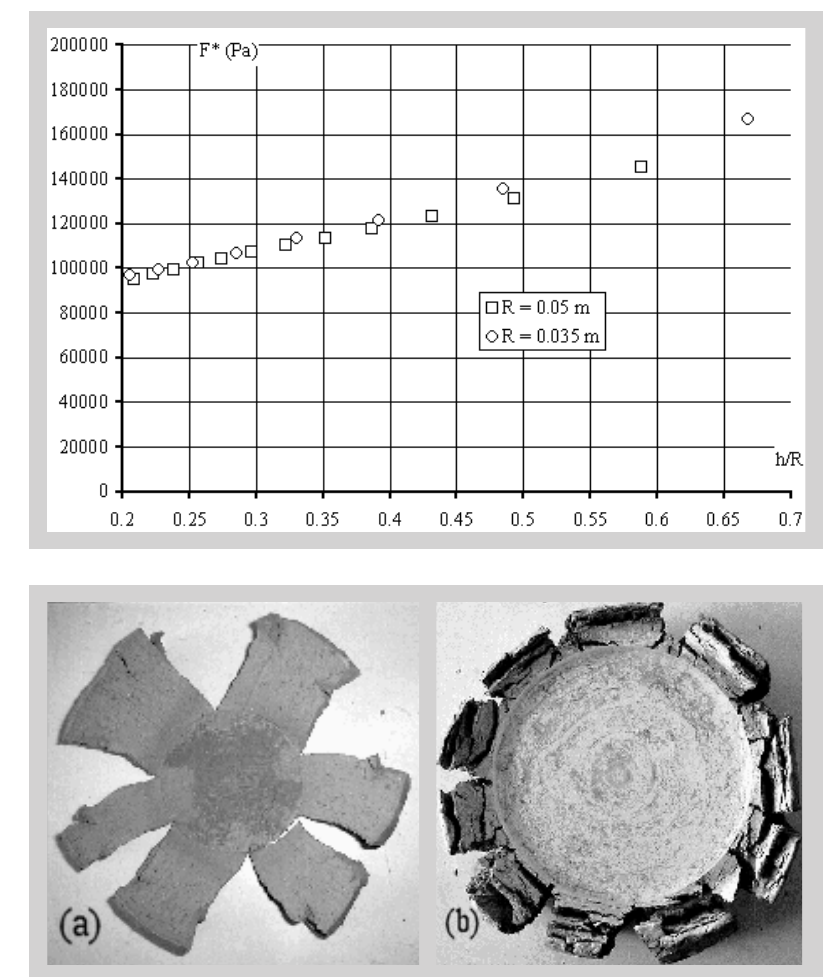
Figure 9 (above): Compression test results (natural soils, rough plates c = 0.4 mm/s). Figure 10 (below): Compression test clay samples. The number of breaks can greatly vary depending on the tested material (a) and